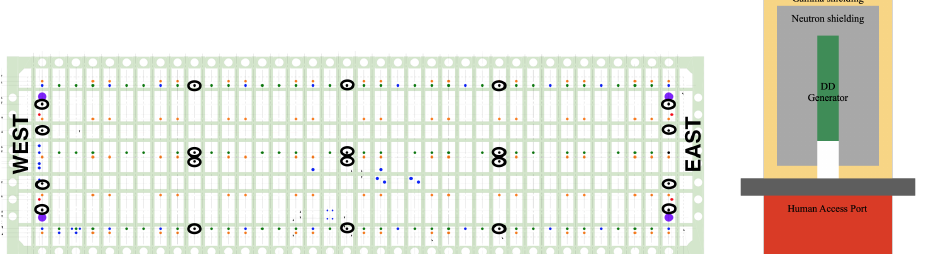
Figure 8. ( left ) Schematic of the DUNE far detector 1 cryostat roof showing the large human access ports (in purple), where the pulsed neutron sources are planned to be installed (in two opposite corners). The possible locations for the laser system are also shown (black ellipses). From [17]. ( right ) Schematic of a pulsed neutron source, including neutron and gamma shielding, mounted on top of a human access port.